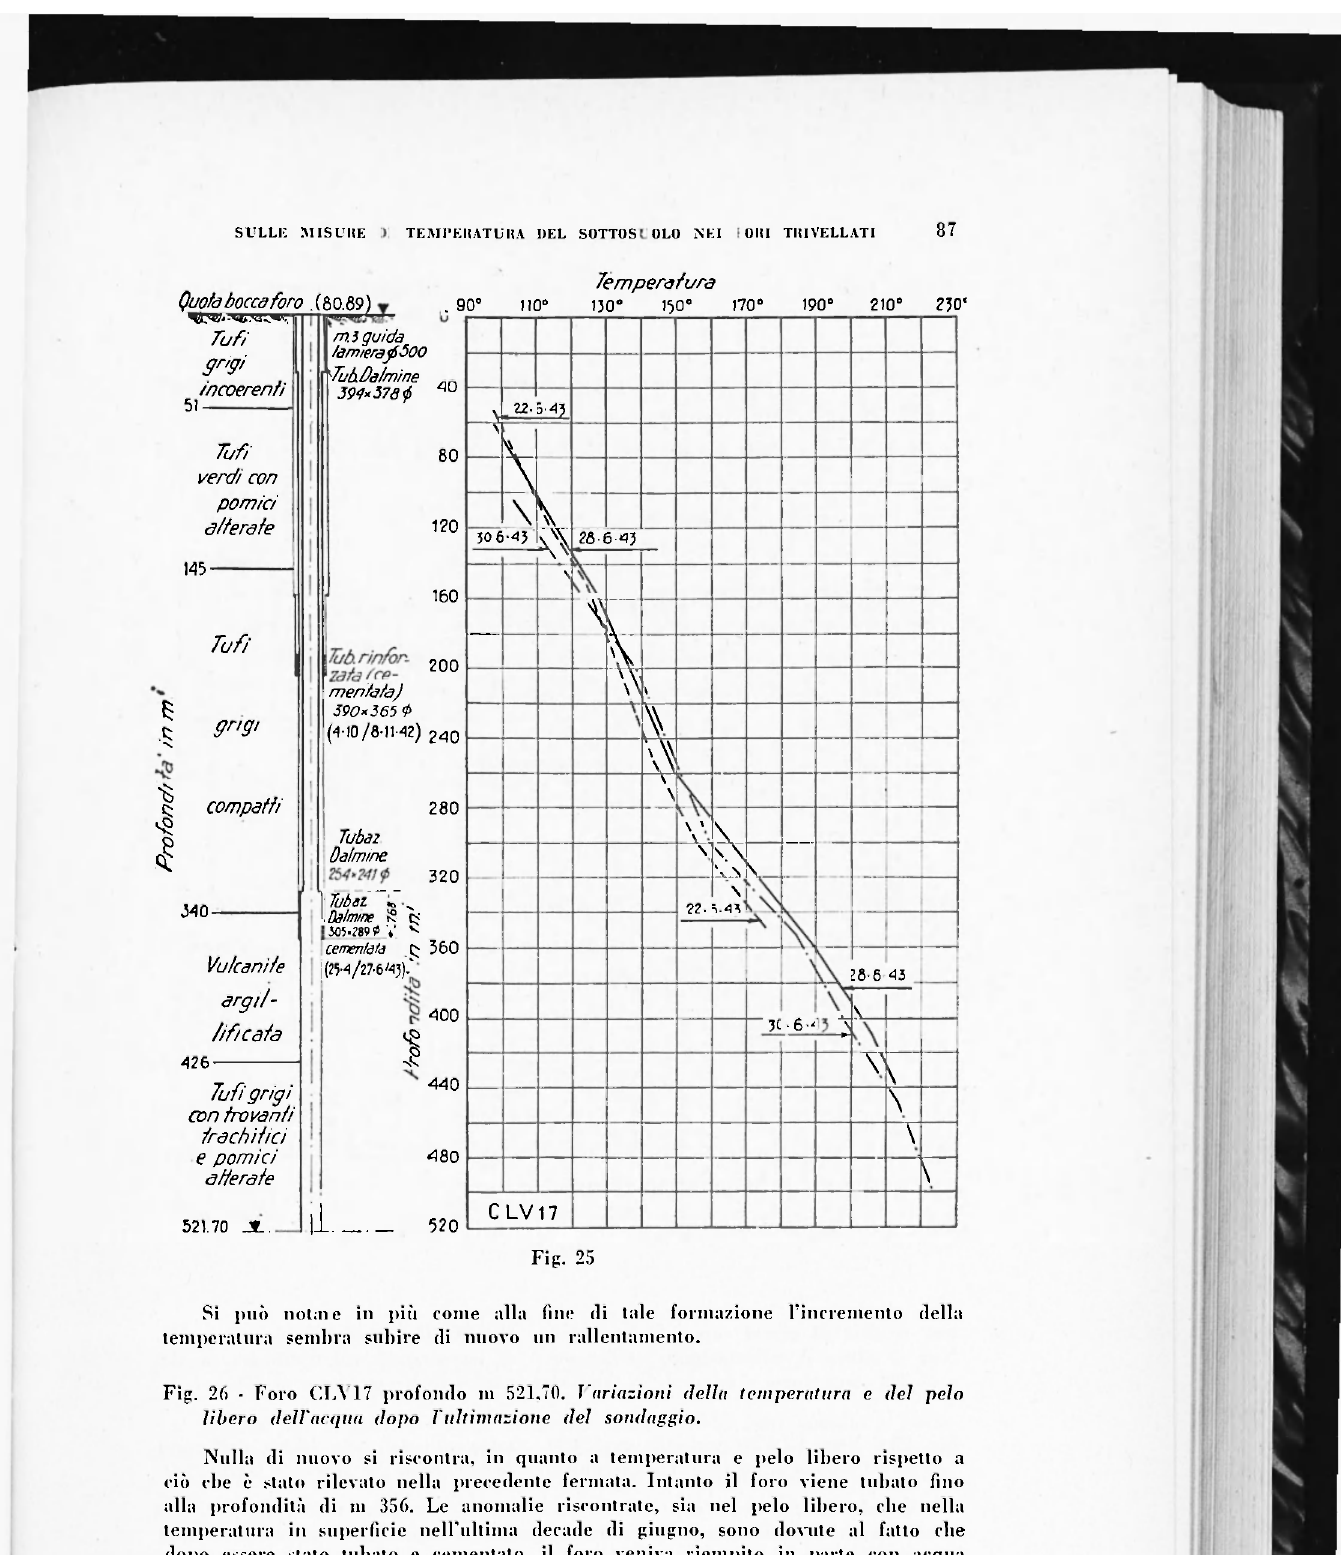
Fig. 26 - Foro CLV17 profondo 111 521,70. Variazioni della temperatura